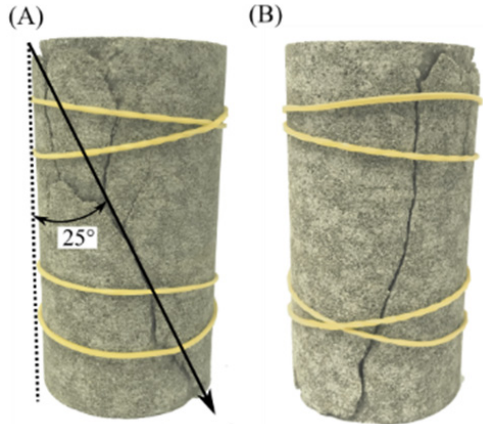
17 of 23 Figure 11. Stress–strain curves of Neijiang sandstone obtained from numerical simulation and la ‐ boratory tests. Lateral strain, axial strain and volumetric strain are obtained from the numerical simulation. Some snapshots of the element strength during failure of the numerical model are extracted and shown in Figure 12. All of these snapshots have the same representative characteristic. As shown in the figure, the distribution of cracks is relatively discrete when the cracks begin to appear in the numerical specimen (Figure 12B). Then, the cracks begin to aggregate when they are very closed to each other (Figure 12C). At the same time, out ‐ lines of the final fracture have begun to form. However, as shown in Figure 12D, some small cracks also appear around the main fracture surface, after the main fracture surface has come into being. Figure 13 shows the failure picture of sandstone in the laboratory tests after the UCS tests, demonstrating that the failure mode obtained from the damage model is very similar to that from the laboratory tests. All of the failure modes from the damage model and the laboratory tests are oblique shear failure, and their inclined angles are almost the same. The damage model can also confirm the phenomenon that some small cracks appear around the main fracture. All of this evidence demonstrates that the proposed damage model has a very good ability to reproduce the instantaneous failure of sandstone, not only as demonstrated in the stress–strain curves, but also as illustrated by the failure mode and fracture evolution. Figure 12. Strength failure snapshots extracted from the simulation result of the damage model. ( A )